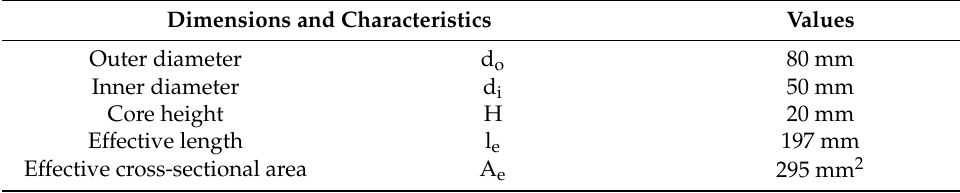
Table 1. Toroidal transformer dimensions